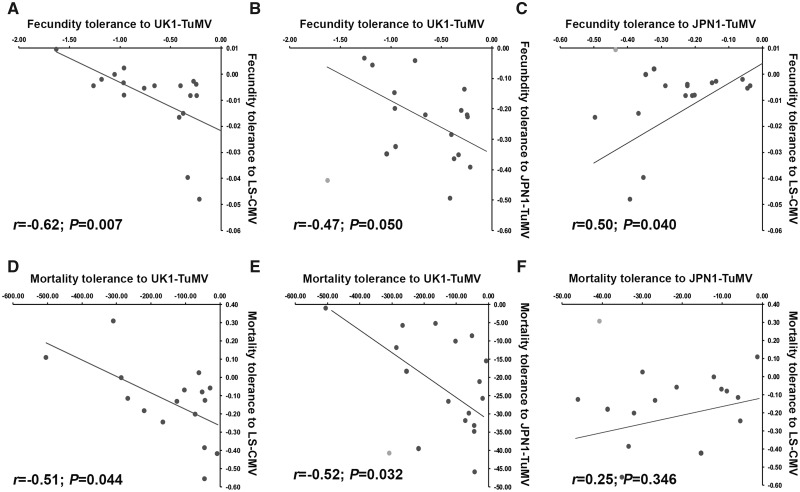
Trade-offs between Arabidopsis tolerances to UK1-TuMV, LS-CMV and JPN1-TuMV. (A–C) Pairwise linear regressions between fecundity tolerance to UK1-TuMV, LS-CMV and JPN1-TuMV. (D–F) Pairwise linear regressions between mortality tolerance to UK1-TuMV, LS-CMV and JPN1-TuMV. Data are slope of the SW (fecundity tolerance) and LP (mortality tolerance) to virus accumulation regression for each Arabidopsis genotype. Grey dots correspond to outlier values, which were excluded from the analyses.